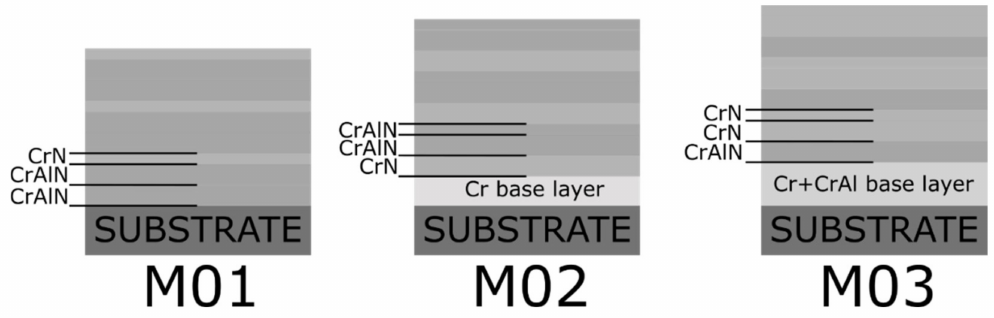
Figure 1. The expected layer distribution based on the different experimental conditions explored in this study including different target combinations and different base